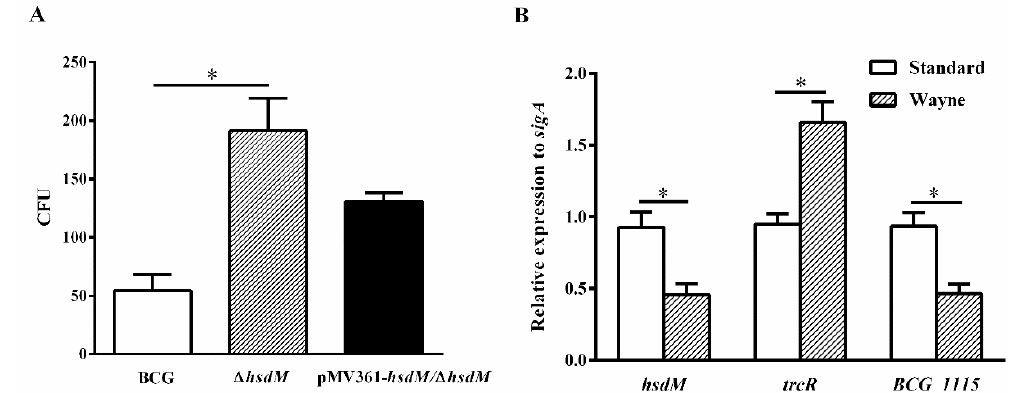
Figure 5. HsdM deletion increased survival of BCG under hypoxia. ( A ) CFUs of the ∆ hsdM , wild-type BCG and complementary strain pMV361- hsdM / ∆ hsdM were detected under the latent Wayne model. ( B ) qPCR analysis of the mRNA expressions of hsdM , trcR and BCG_1115 in BCG between the latent Wayne model and standard culture. * p < 0.05.